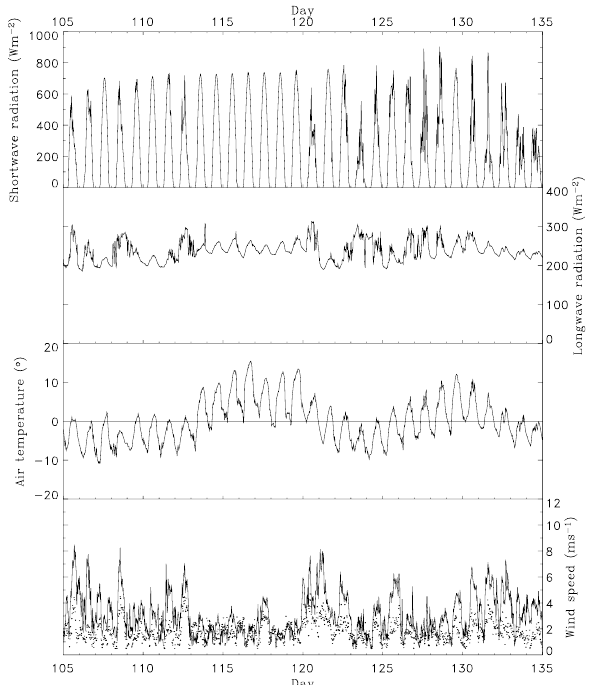
Fig. 3. Meteorological data for 15 April to 14 May 2003 at the plateau site. Dotted line shows wind speeds at the valley site. Radi- ation fluxes are incoming to the surface.